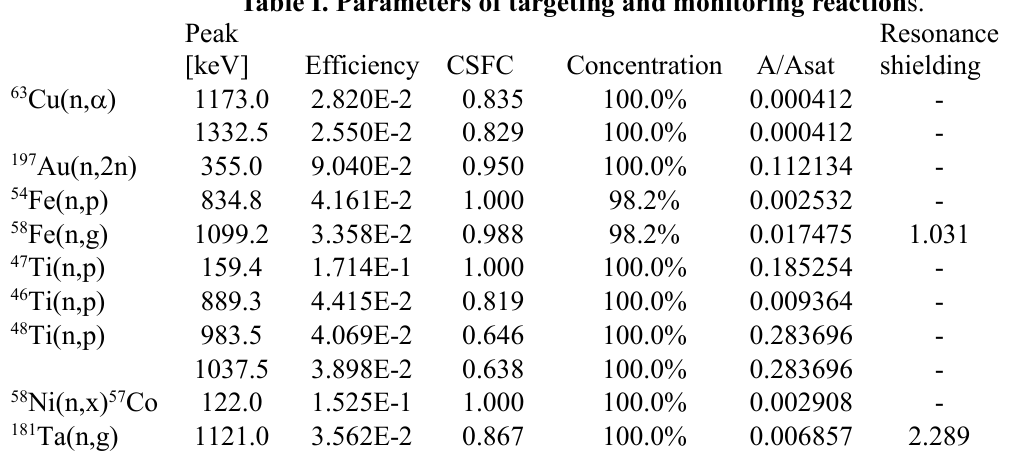
Table I. Parameters of targeting and monitoring reaction